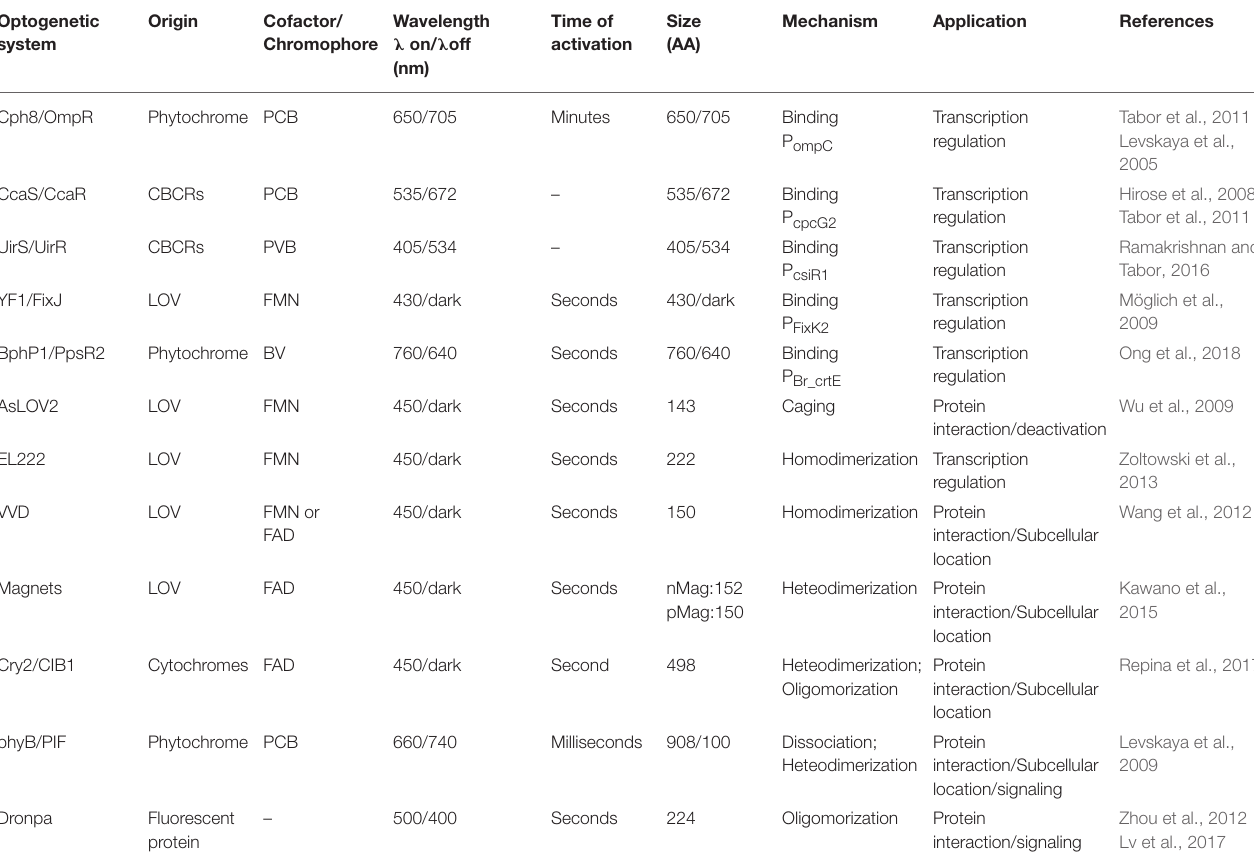
TABLE 1 | Summary of optogenetic system